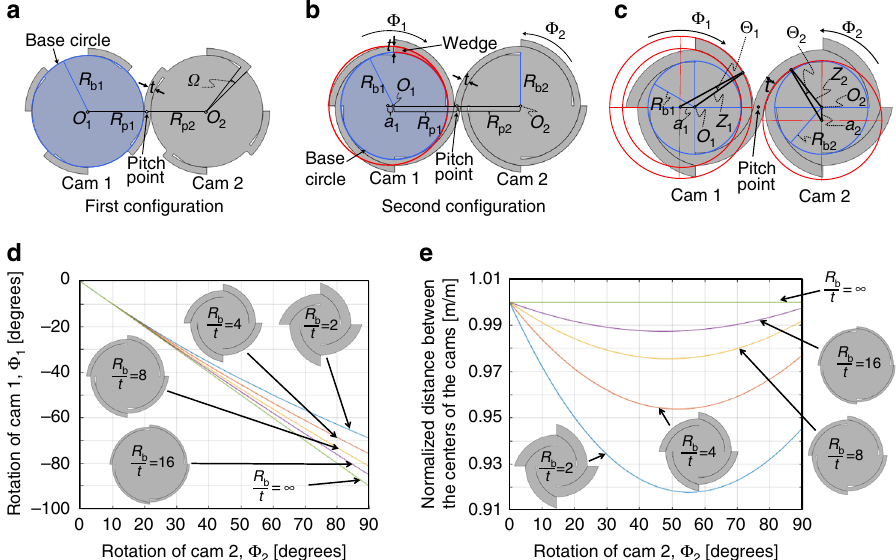
Fig. 4 Two strap con fi gurations. a First and b second way straps can be wrapped around neighboring cams. c Parameters used to model the kinematics of cams wrapped using the second con fi guration. d The rate that each cam rotates as well as e the distance between the cams ’ centers will fl uctuate for cams wrapped using the second con fi guration even for cam pairs that possess the same base-circle